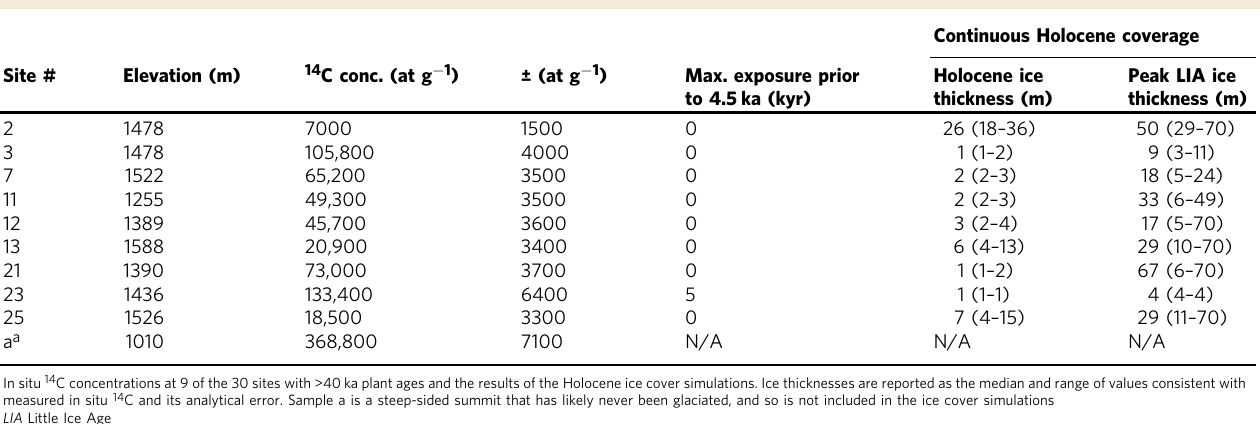
Table 2 In situ 14 C concentrations and ice cover simulations